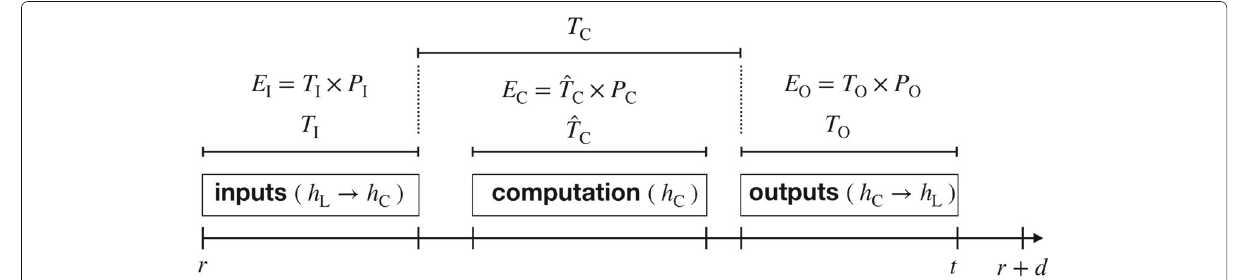
Fig. 2 Illustration of system model